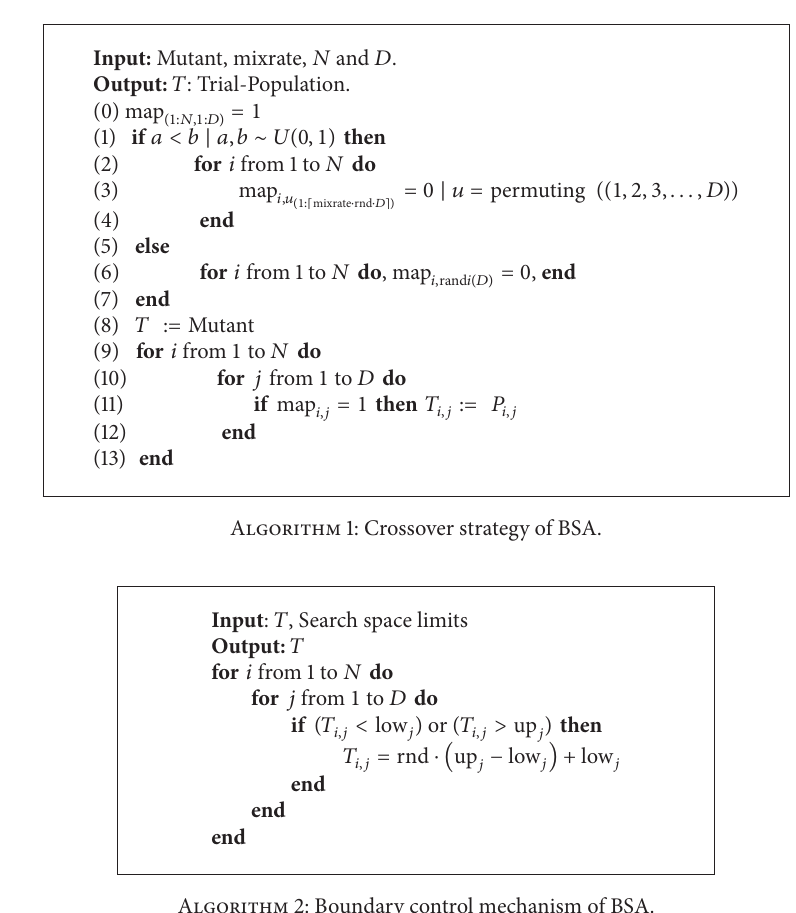
Algorithm 2: Boundary control mechanism of